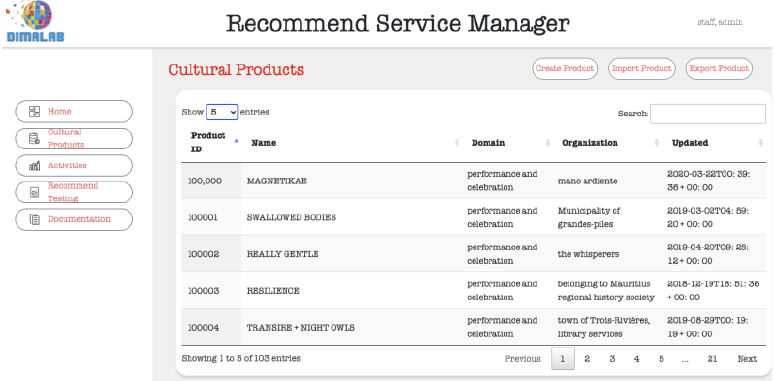
Fig. 2. Data-as-a-Service.